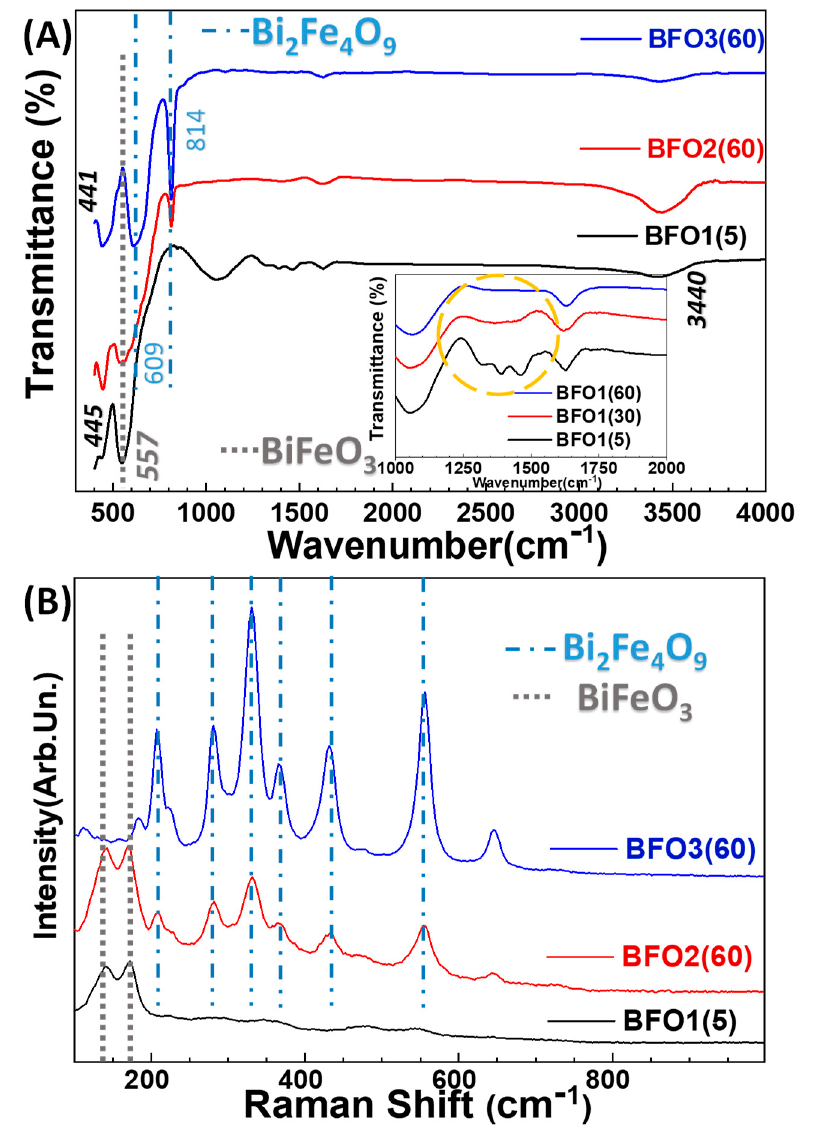
Figure 3. ( A ) FT-IR spectra for BFO materials in the range 400 to 4000 cm − 1 . Inset : zoom into the hydrocarbon’s region. ( B ) Raman spectra for BFO materials. In both graphs, characteristic peaks that differentiate the two phases BiFeO 3 and Bi 2 Fe 4 O 9 are marked with dashed lines.